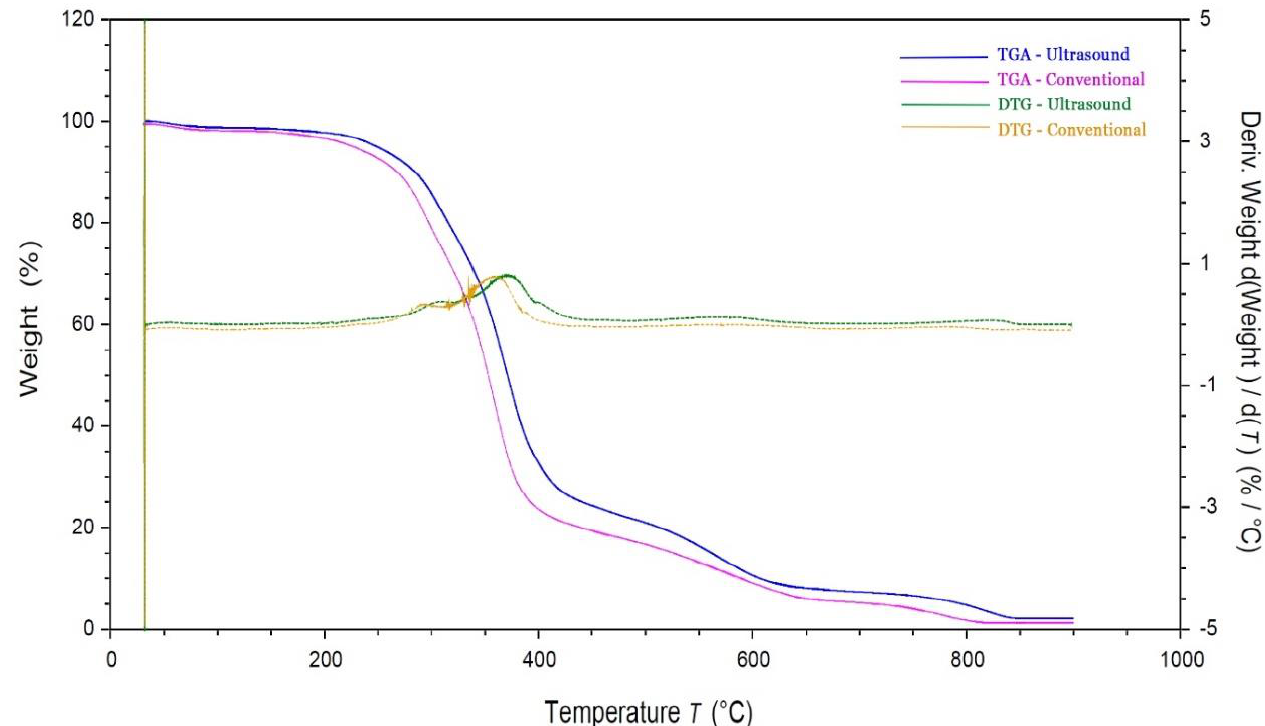
Figure 4. TGA and DTG thermograms of cherimoya-seed-protein concentrates obtained by ultra- sound and conventional extraction techniques.